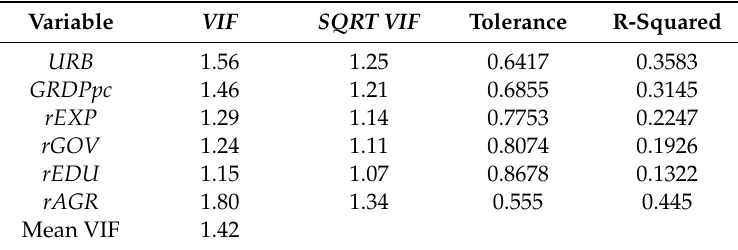
Table 4. Checking